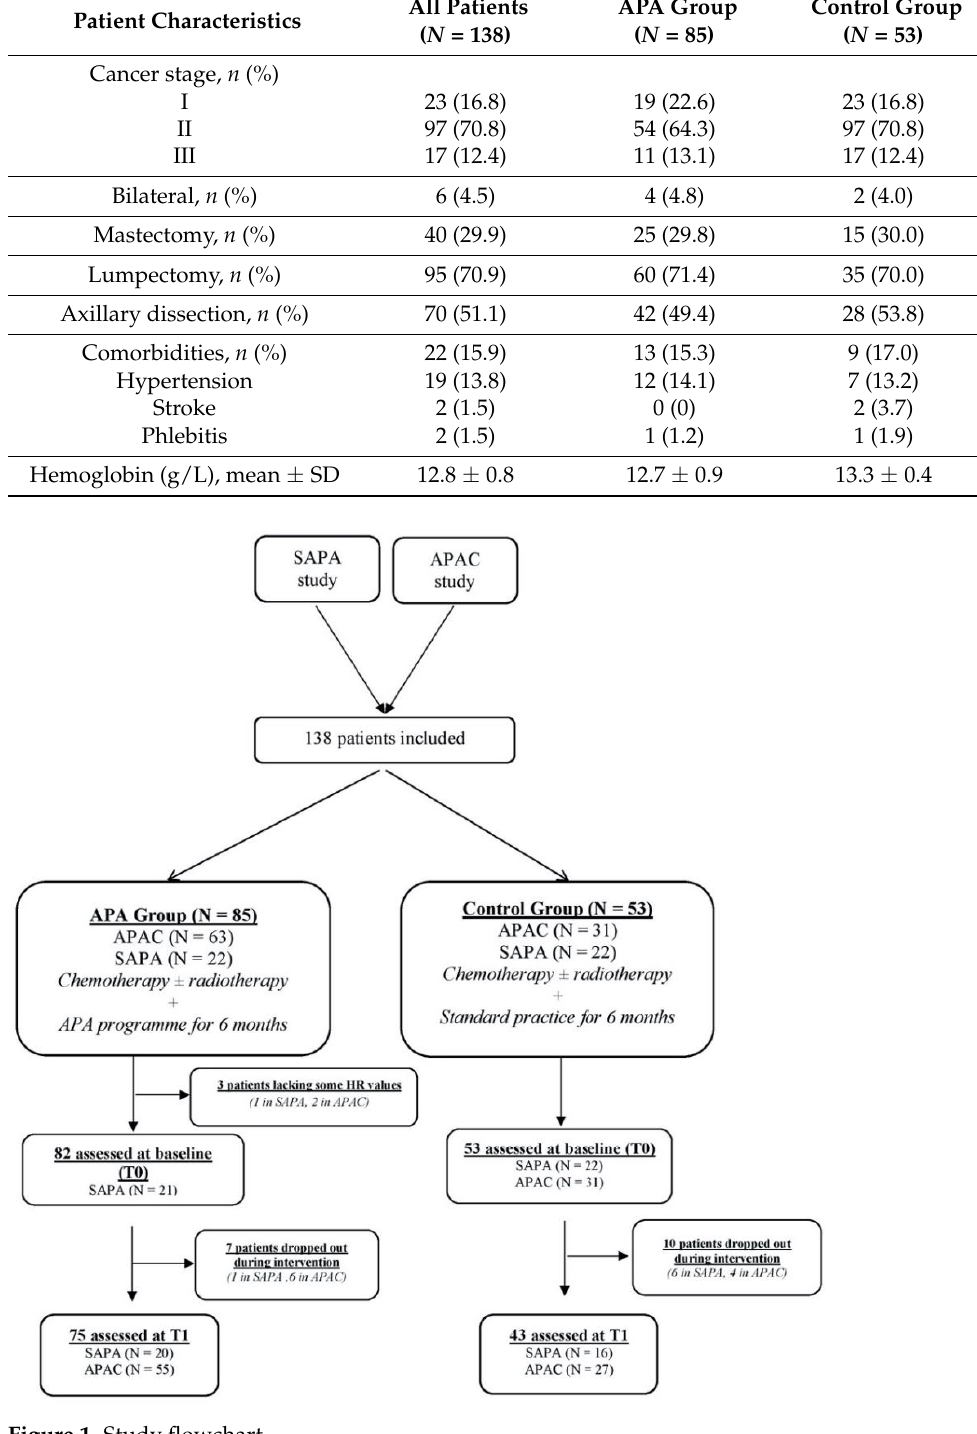
Figure 1. Study Figure 1. Study flowchart. Table 1. Patient characteristics at baseline ( N = 138).